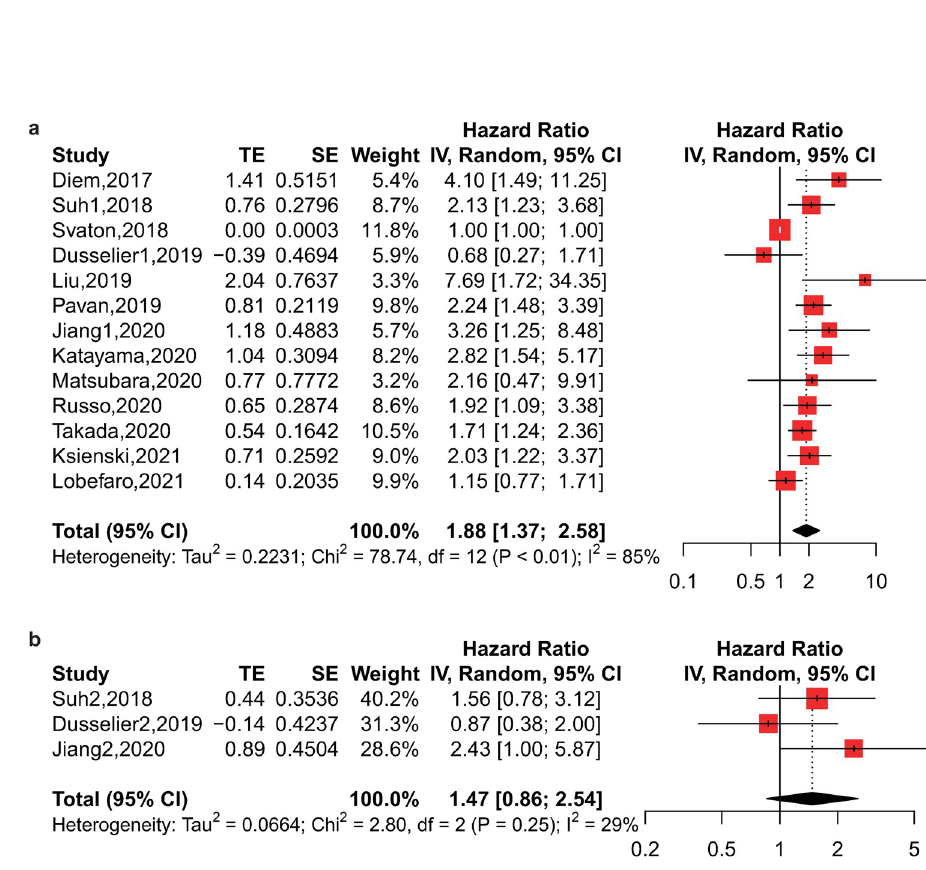
Fig 2. Forest plot of the association between PLR and OS of lung cancer patients receiving immunotherapy. a) Forest plot of pretreatment PLR; b) Forest plot of posttreatment PLR.